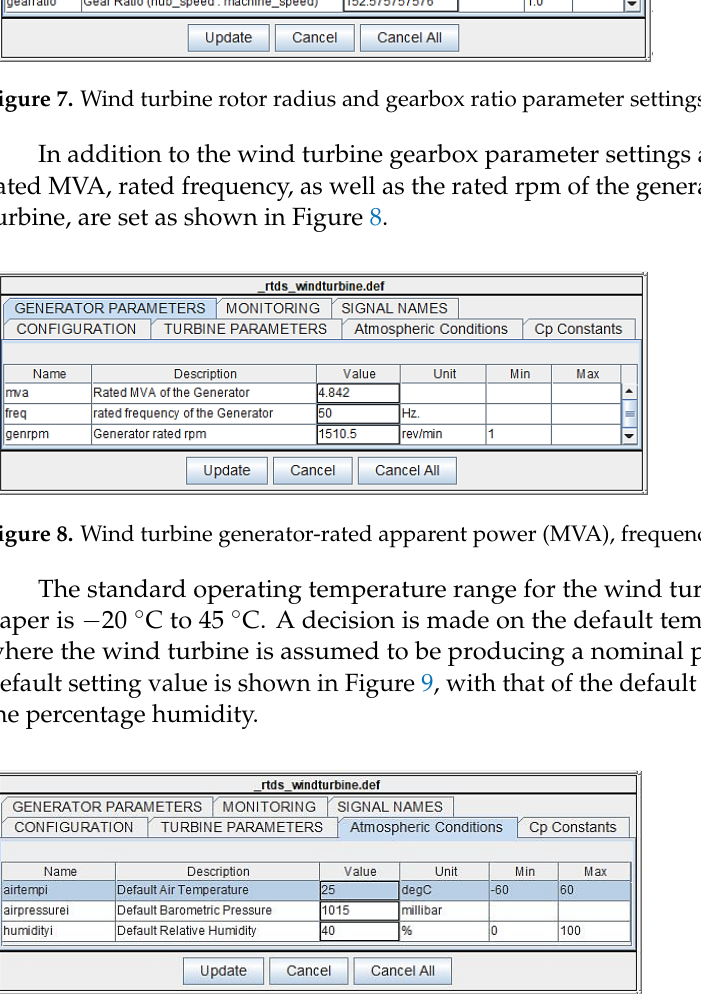
Figure 9. Setting values for the default air temperature, barometric pressure, and relativity.